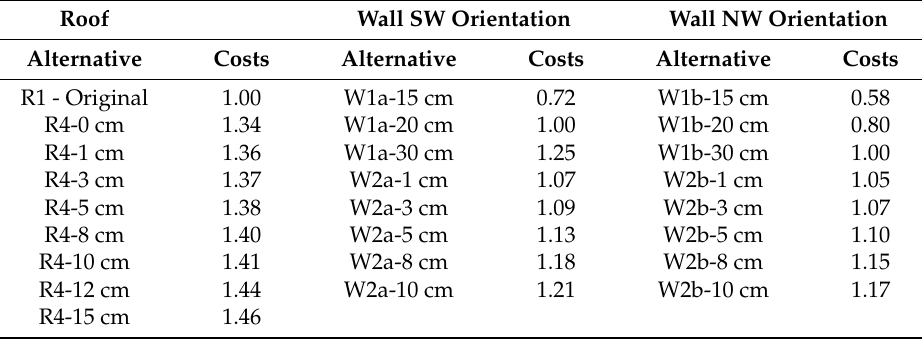
Table 13. Costs involved for each alternative under consideration.